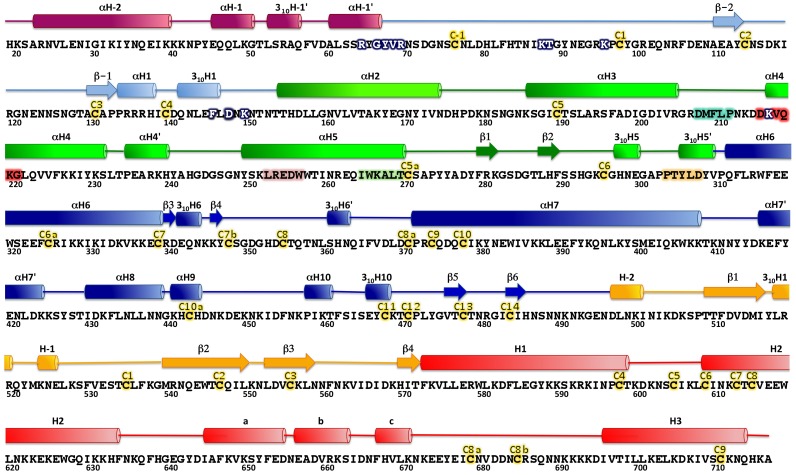
Sequence and secondary structure of DBL1α1-CIDR1γ VarO-Head region.The sequence is indicated in single letter code. Cylinders represent helices and arrows represent β strands. NTS is mauve; DBL1α1 subdomains 1, 2, and 3 are light blue, green, and blue, respectively, while CIDR1γsubdomains 1 and 2 are orange and red, respectively. Cysteines, given by their canonical nomenclature, are in yellow. DBL1α1 helices up to αH8 without primes (′) refer to helices common to all known DBL structures. Mutations that affect RBC binding are highlighted as white letters on a dark blue background. The sequences corresponding to the PolV tags are shown with backgrounds cyan (PolV1), pink (PolV2), green (PolV3) and orange (PolV4). Motif H3 is shown in red.